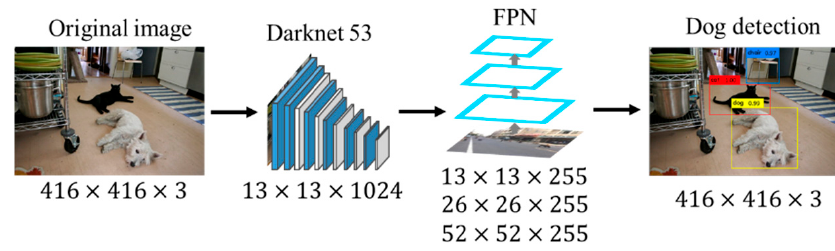
Figure 2. Dog detection.